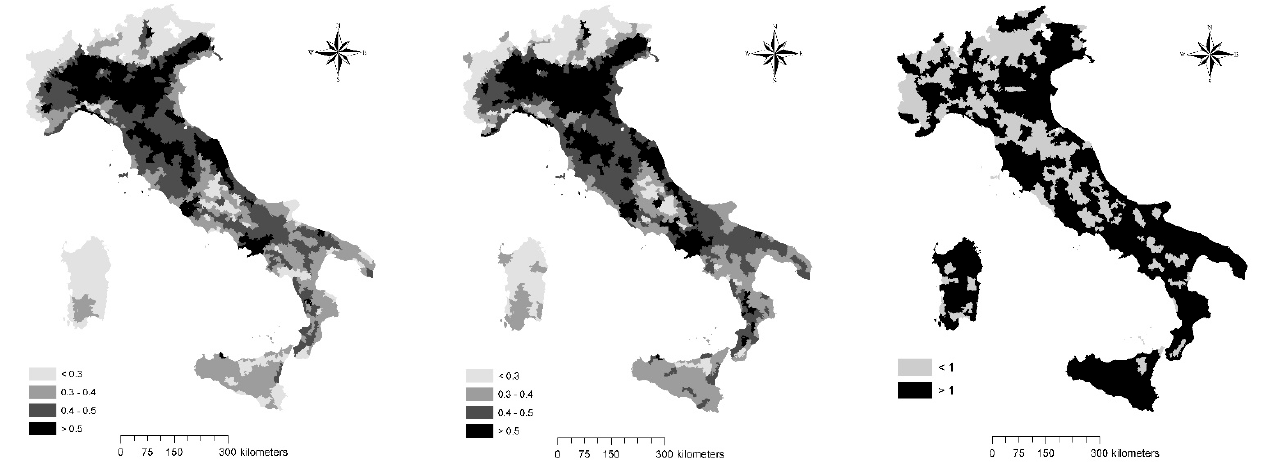
Figure 2. Spatial distribution of the absolute ratio of socioeconomic-to-biophysical indicator of soil sensitivity to degradation in Italy ( left , the Early-1990s; middle : The Early-2010s; and right : Change over time, where “<1” indicates a decreasing ratio, “>1” denotes an increasing ratio).